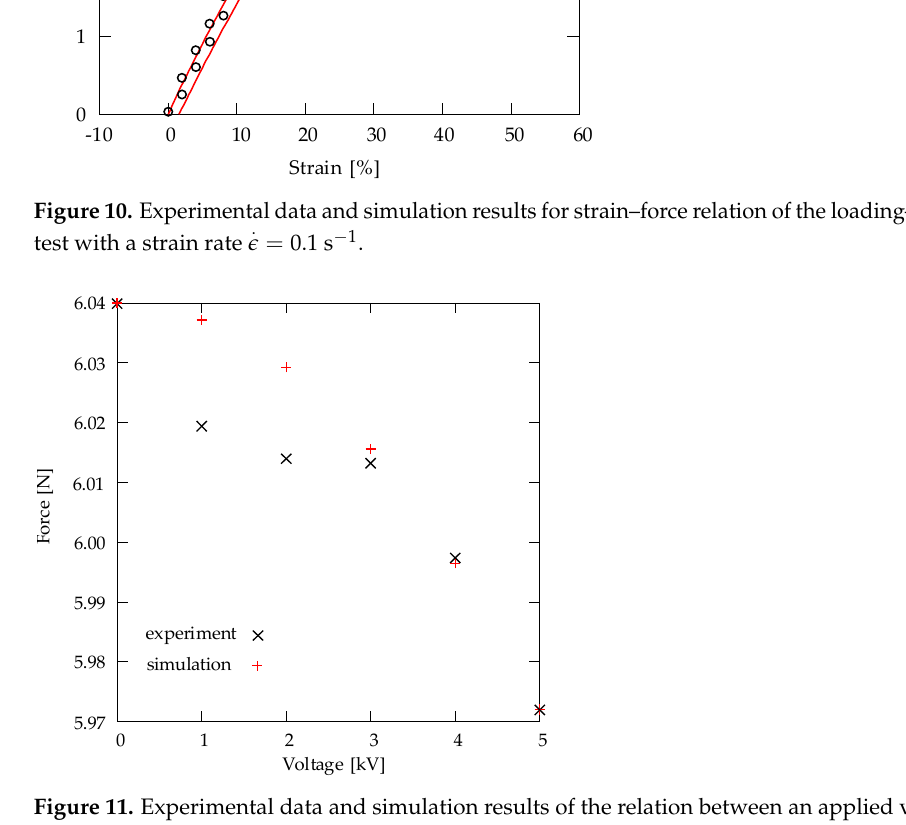
Figure 11. Experimental data and simulation results of the relation between an applied voltage and the maximum force. the maximum